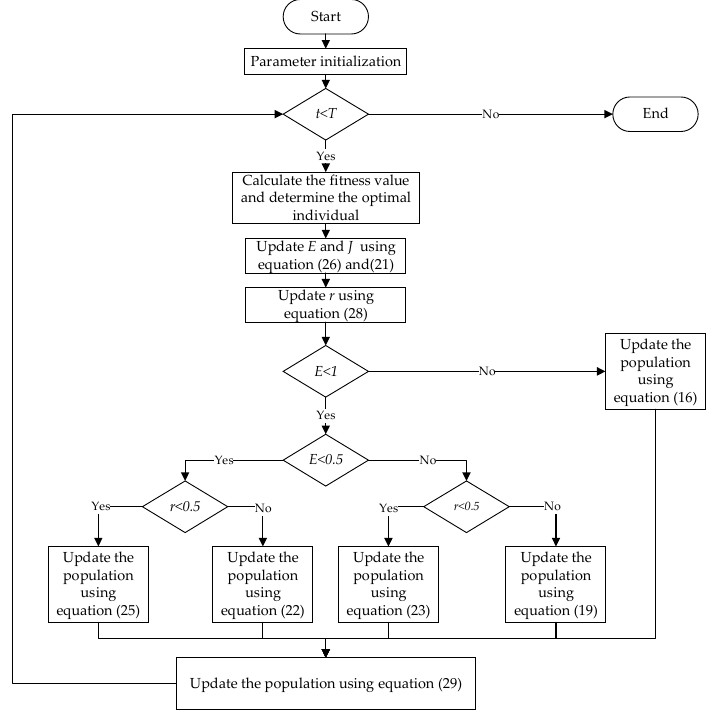
Figure 5. The flow chart of the CMHHO algorithm.